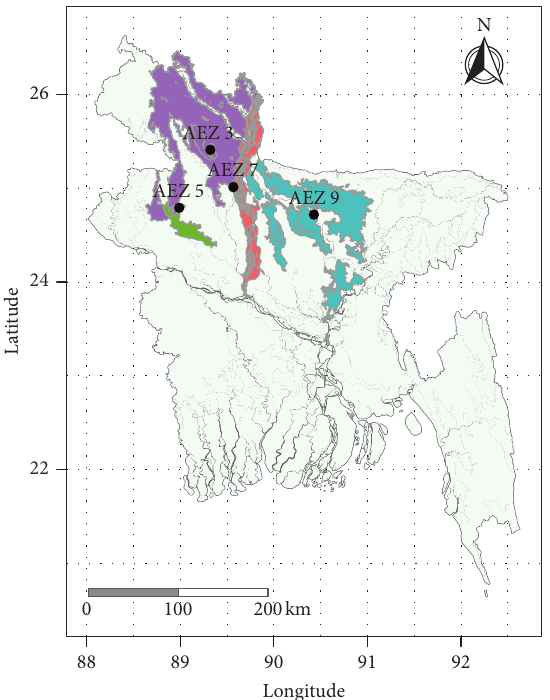
Figure 1: Geographical location of the selected sites of Bangladesh. Four coloured regions are showing the four selected agroecological zones (AEZs) of Bangladesh. The black dots are showing the po- sition of the selected upazila (a subunit of a district in Bangladesh) in four AEZs: AEZ-7 (active Brahmaputra-Jamuna floodplain) � Sonatola Upazila, Bogra, AEZ-3 (Tista Meander floodplain) � Pirganj Upazila, Rangpur, AEZ-9 (Old Brahmaputra floodplain) � Bangladesh Agricultural University, Mymensingh, and AEZ-5 (lower Atrai basin) � Adamdighi Upazila, Bogra,